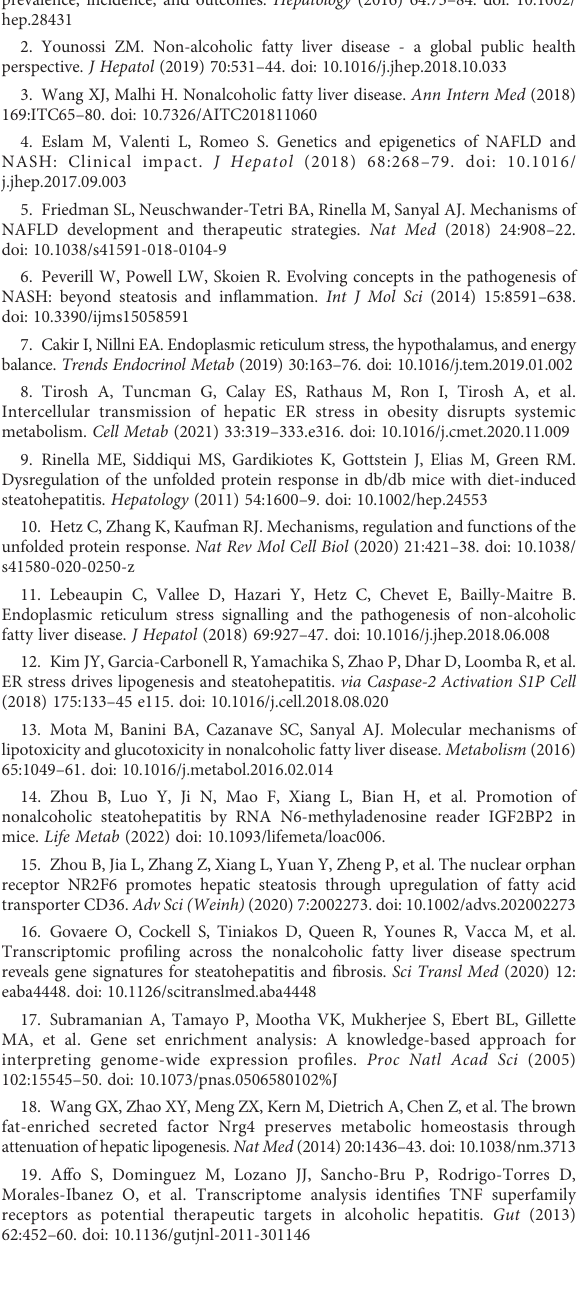
represent the intersection among each gene set. (B) Hierarchical clustering dendogram of the samples. The vertical axis represents the distance among samples to illustrate the clusters. The red line represents the height of 45000 to fi nd out the obvious